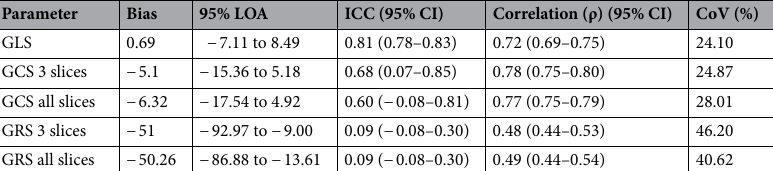
in the supplementary Table S3, multivariate analyses calculated for automated GLS/GCS/GRS separately are shown in supplementary Table S4. Amongst automated derived functional parameters GLS emerged as the only tary Table S5). In addition to patients characteristics angiographic data and CMR derived tissue characterisation, either manual LVEF and GLS or automatically derived LVEF and GLS were included to the multivariate analyses. Both parameters performed equally with manual or automated GLS being an independent predictor for MACE (manual GLS HR 1.12 95% CI 1.05–1.18, p < 0.001 and automated GLS HR 1.15 95% CI 1.06–1.24, p = 0.001). Dichotomization at the median of respective strain values was performed to assess risk stratification using Kaplan–Meier curves Fig. 5. GRS curves are shown in the supplementary Figure S3. Both manual and automated analyses of GLS and GCS were significantly associated with MACE ( p < 0.001 for all). As appreciated from AUC statistics, automated analyses were non-inferior for risk prediction compared to the reference standard of manual